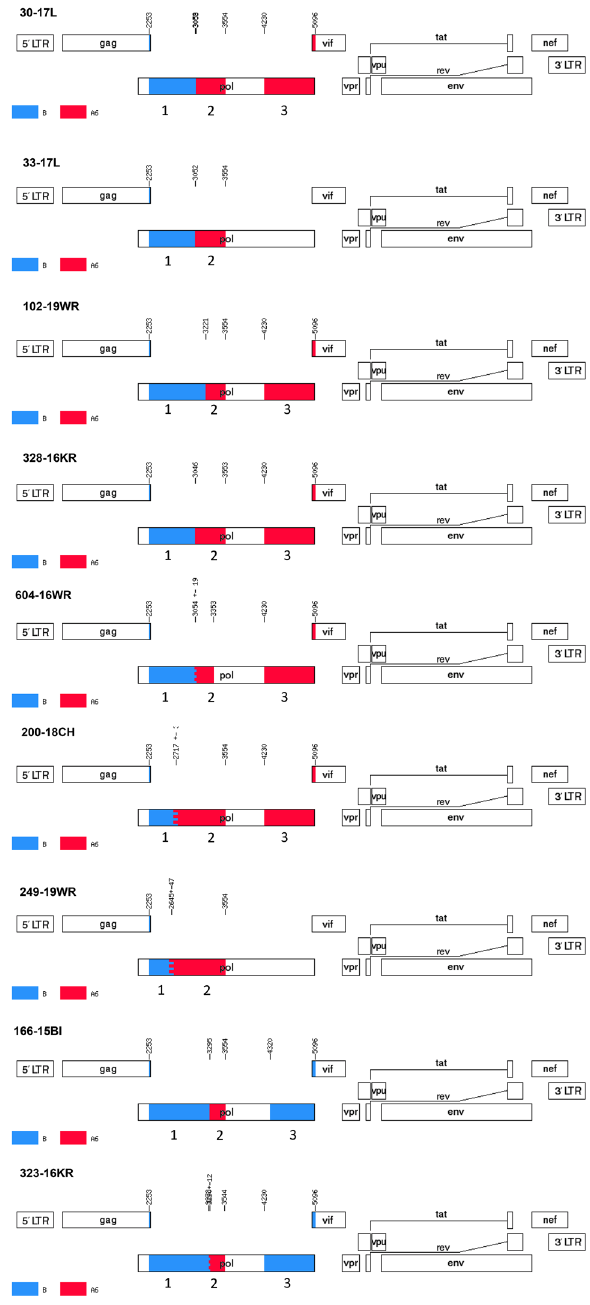
Figure 6. Recombination pattern of the nine partial HIV-1 pol sequences from the identified A6B Cluster II. Analysed region include the protease with a fragment of the reverse transcriptase gene (2253–3554 bp) and the integrase gene (4230–5096 bp). In two cases (33-17L, 249-19WR) IN gene was not sequenced. Recombination breakpoints (according to HXB2 genome positions) were obtained using Simplot v3.5.1 software and jumping- profile hidden Markov model (jpHMM). The blue color stands for HIV-1 subtype B, red color stands for sub-subtype A6. Component subtype regions are labeled from 1 up to 3 on the genome map, corresponding with numbered on phylogenetic trees in Supplementary Figure S5. The mosaic map was generated using the Recombinant HIV-1 Drawing Tool (https:// www. hiv. lanl. gov/ conte nt/ seque nce/ DRAW_ CRF/ recom_ mapper.